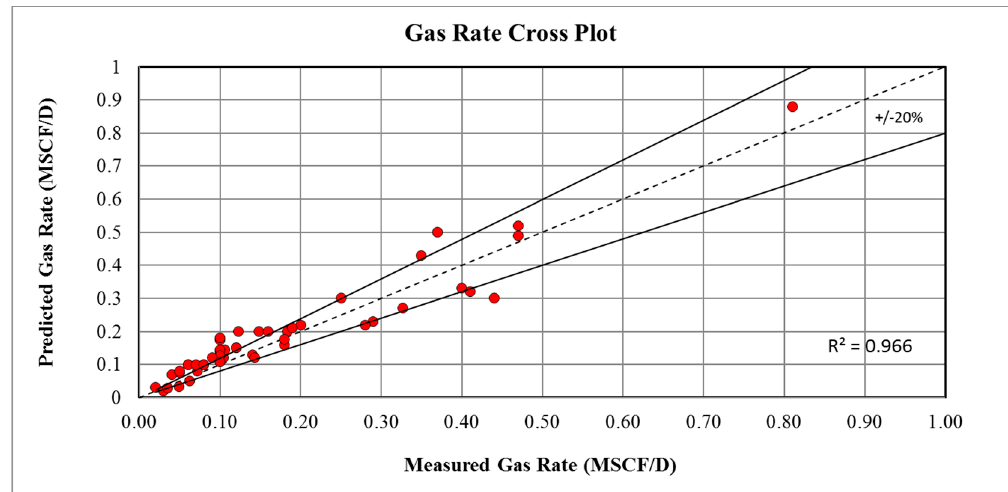
Figure 10. Predicted vs measured gas rate using the Blasius correlation.